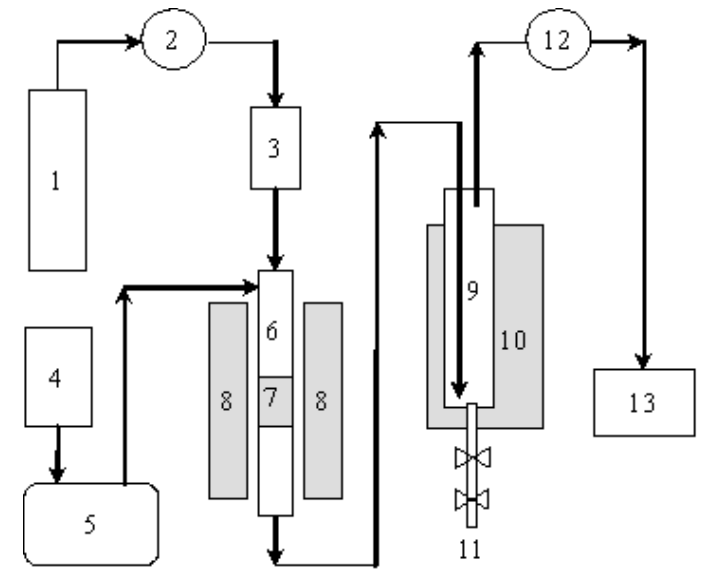
cylinder; ( 2 ) pressure 2